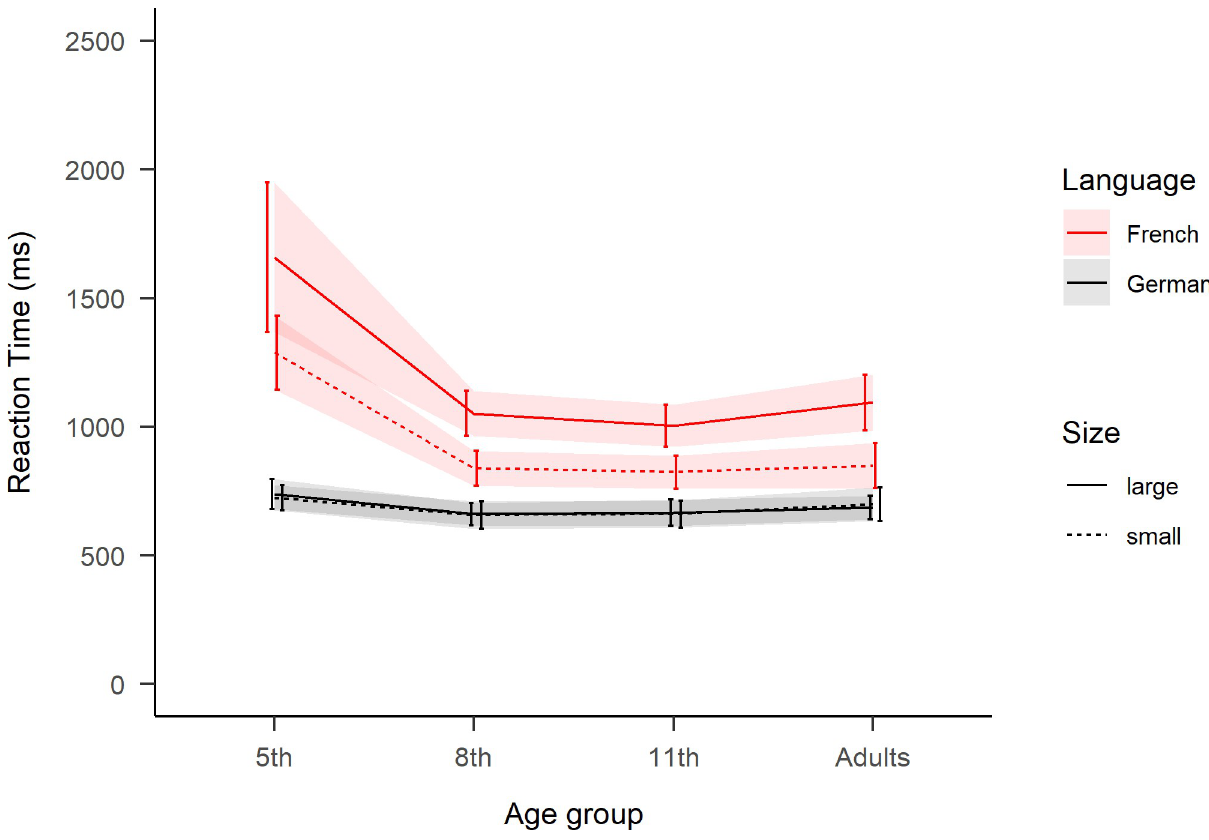
Fig 2. Reaction times of the reading aloud task. For each age group as a function of “Language” and “Number Size”. Large numbers correspond to ‘70s, ‘80s and ‘90s, while small numbers correspond to ‘30s, ‘40s and ‘50s. Ribbons represent standard error.